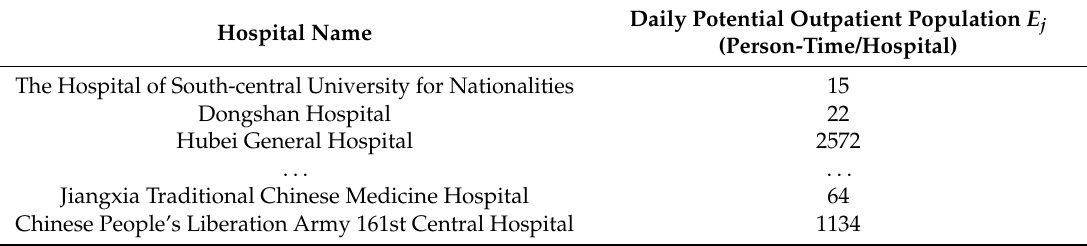
Table 3. Daily potential outpatient population of each hospital in